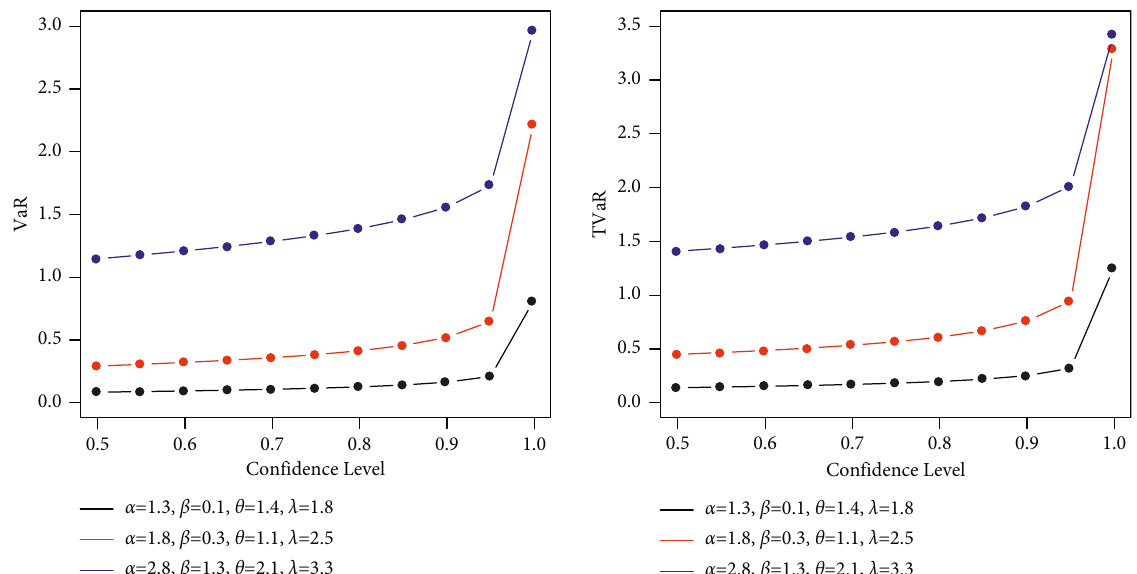
Figure 4: VaR and TVaR plots of the EFL